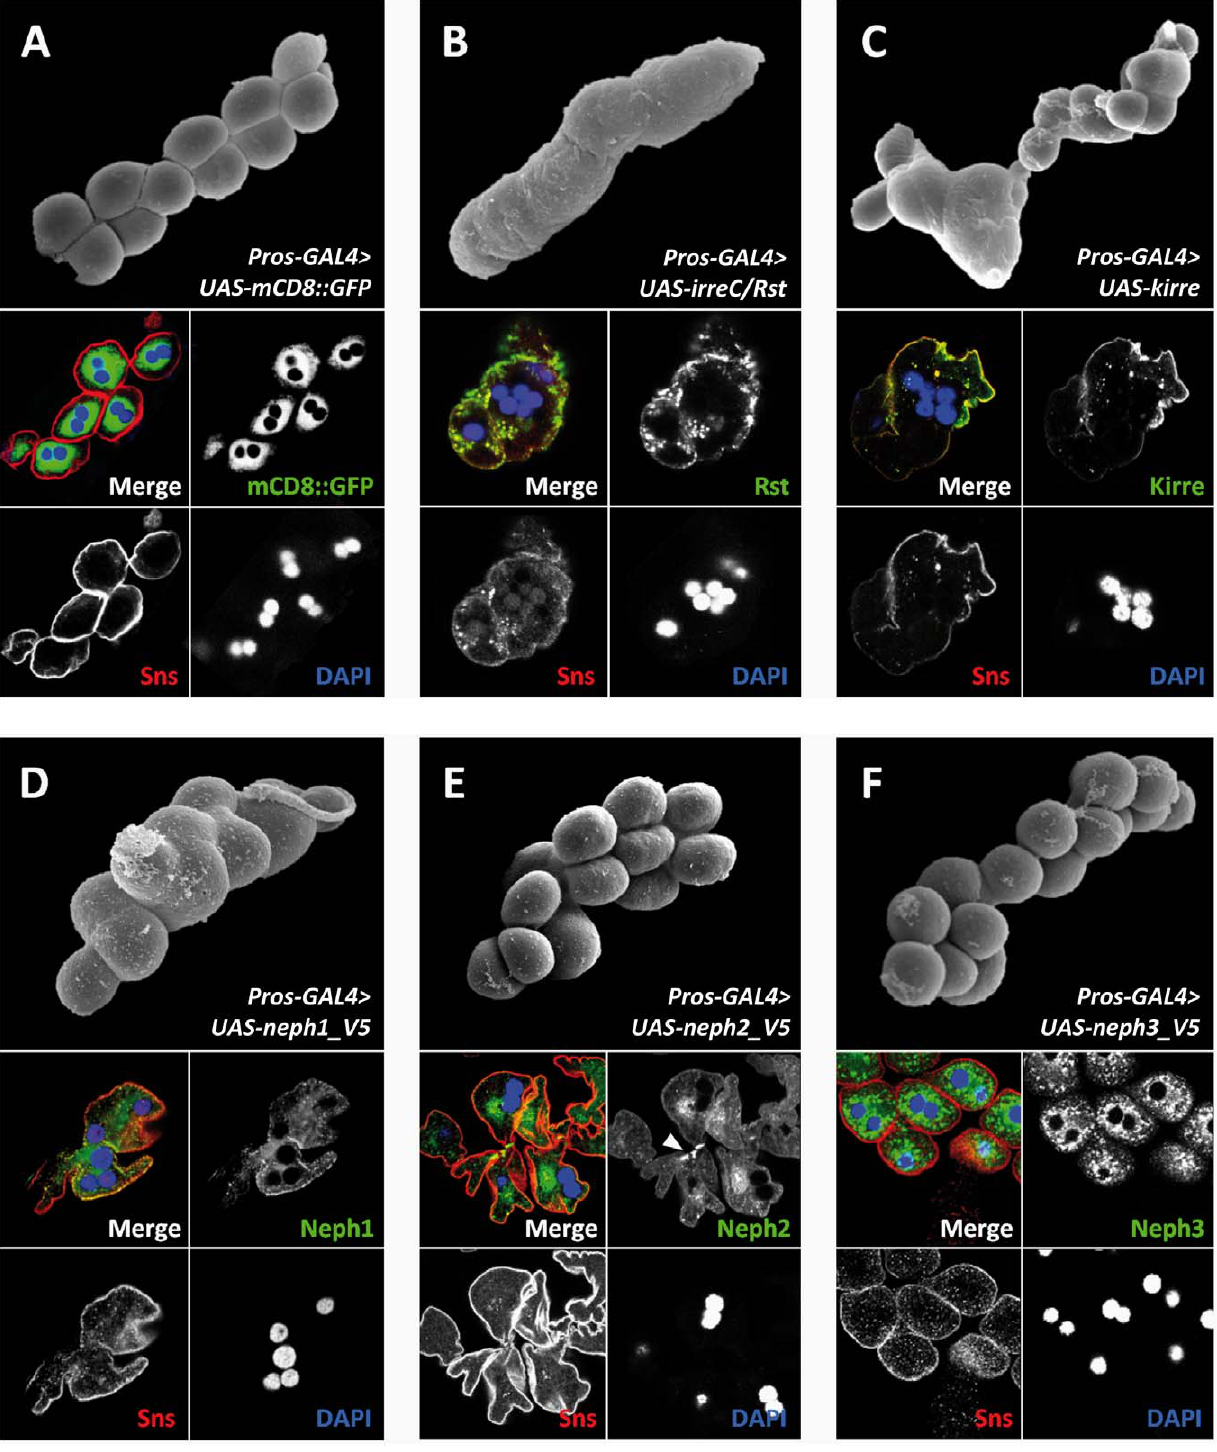
Figure 2. IRM protein misexpression in GCNs can induce clustering and/or hyperfusion. A-F. Scanning electron micrograph of Drosophila GCNs at third larval stage and immunoreactivity of the corresponding genotypes. The control shows the distribution of misexpressed membrane associated mCD8::GFP. The misexpressed protein is endocytosed if it is not stabilized in the nephrocyte diaphragm. The binucleate GCNs are separated ( A ). IrreC/Rst misexpression leads to clustering and hyperfusion of GCNs ( B ). Kirre overexpression leads to a similar phenotype. ( C ). Neph1 misexpression also leads to clustering and fusion of GCNs ( D ) . Neph2 misexpression does not interfere with the fusion of GCNs ( E ). The arrow head marks the enriched Neph2 immunoreactivity at cell-cell contacts. Misexpression of Neph3 does not interfere with the GCN fusion. Immunoreactivity shows that the Neph3 expression pattern is similar to the GFP control ( F ).